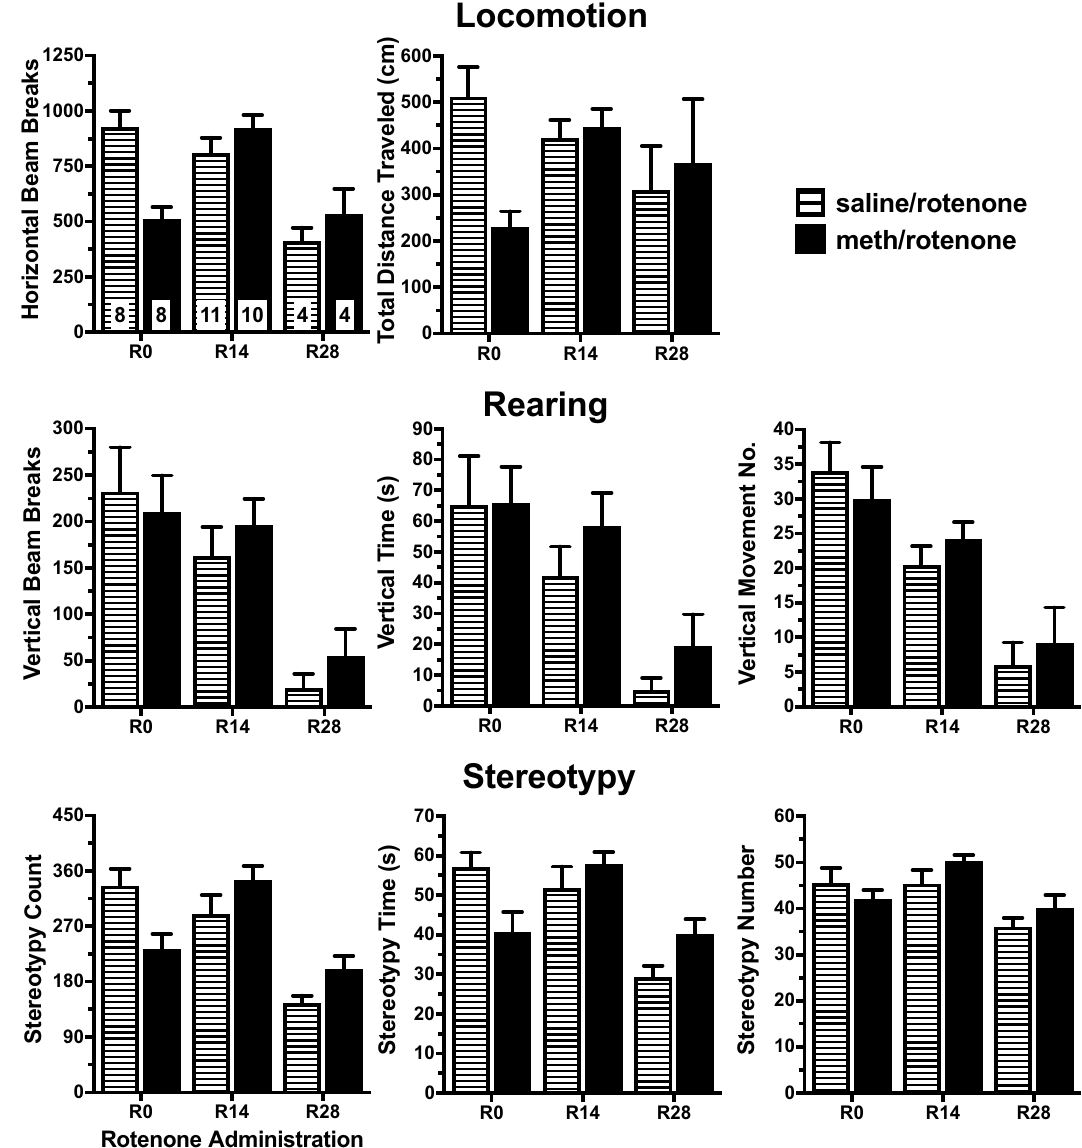
Figure 7. Onset phase motor effects of rotenone administration time on the expression of behavioral sensitization after a methamphetamine (meth) acute challenge. Administration of rotenone to saline-yoked rats on R28 reduced horizontal beam breaks, vertical beam breaks, vertical time, vertical movement number, stereotypy count, and stereotypy time compared to R0 saline/rotenone rats. Compared to R14 saline/rotenone rats, R28 rats had reduced horizontal beam breaks, vertical beam breaks, stereotypy count, and stereotypy number. R14 administration reduced vertical movement number in R14 saline/rotenone rats compared to R0 saline/rotenone rats. R0 meth/rotenone rats had reduced horizontal beam breaks, total distance traveled, and stereotypy count compare to R0 saline/rotenone rats. R14 meth/rotenone rats had increased horizontal beam breaks, total distance traveled, and stereotypy count compared to R0 meth/rotenone rats. R28 meth/rotenone rats had reduced horizontal beam breaks, vertical movement number, and stereotypy count compared to R14 meth/rotenone rats and lower vertical beam breaks, vertical movement number, and stereotypy count compared to R0 meth/rotenone rats. The first bar graph contains the samples size for each treatment